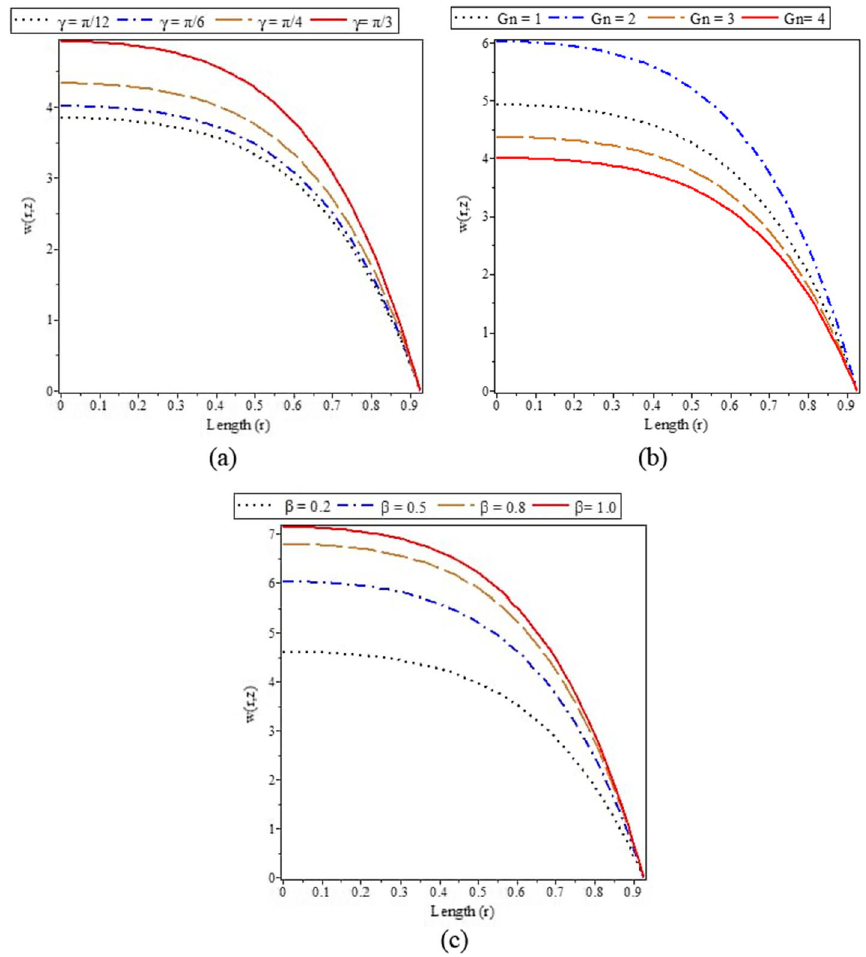
Fig. 2 Influence of Inclination angle (γ) , nonlinear thermal convection term ( G N ), and Casson parameter on the velocity